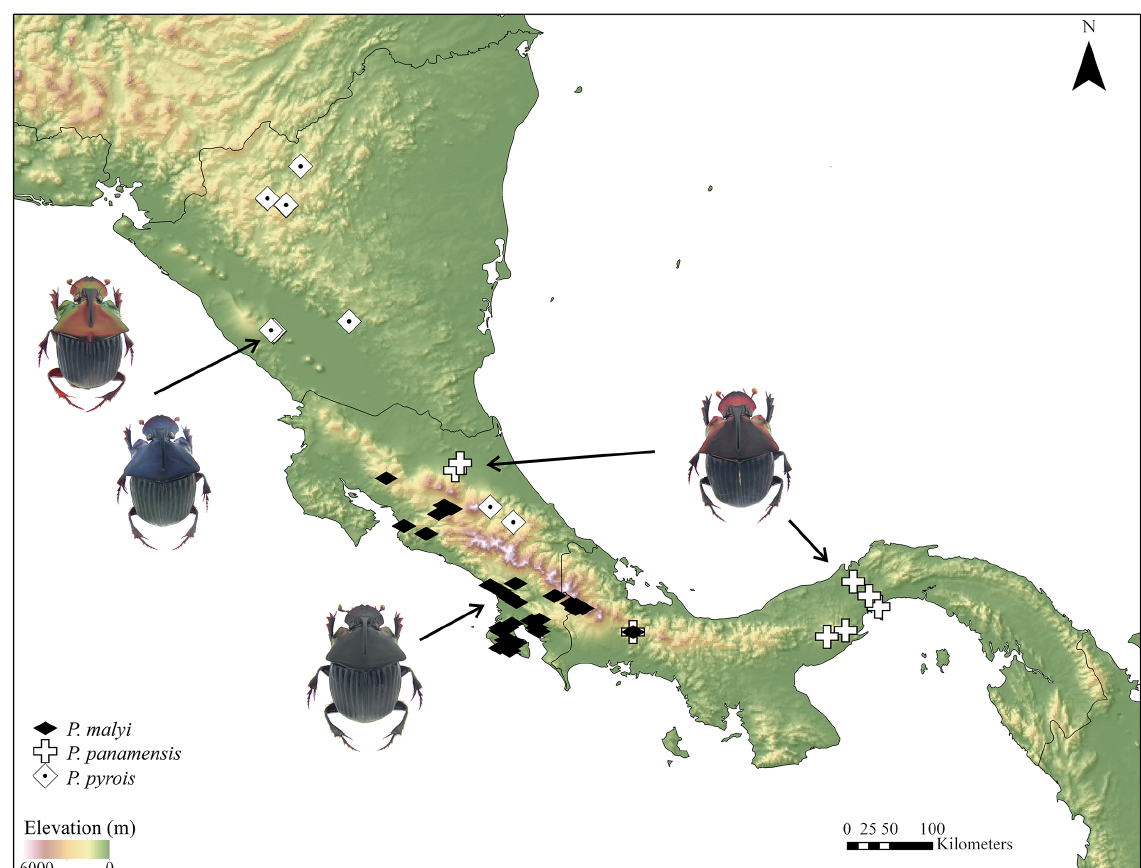
Fig. 16. Distribution of the Phanaeus endymion species group in Central America (in